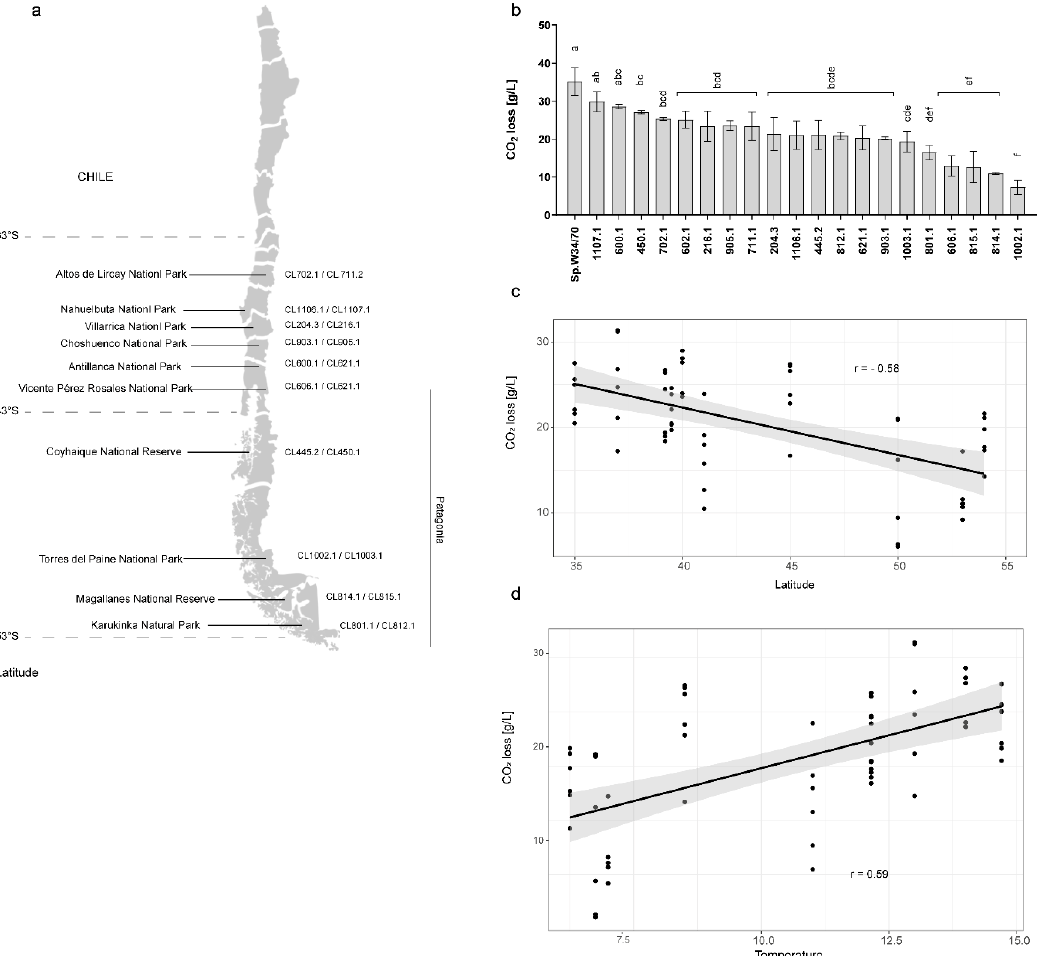
Figure 1. Saccharomyces eubayanus fermentation performance in lager wort. ( a ) The geographical location of the sampling sites and the strain codes from each locality. ( b ) Total CO 2 loss [g / L] in fermentations carried out by S. eubayanus strains. Lager strain S. pastorianus W34 / 70 was used as a fermentation control. Di ff erent letters reflect statistically significant di ff erences between strains with a p -value < 0.05, one-way ANOVA. ( c ) Latitude and ( d ) annual average temperature at the isolation site of each strain vs. CO 2 loss (Pearson Correlation). Each dot represents a fermentation replicate. Three biological replicates were analyzed per